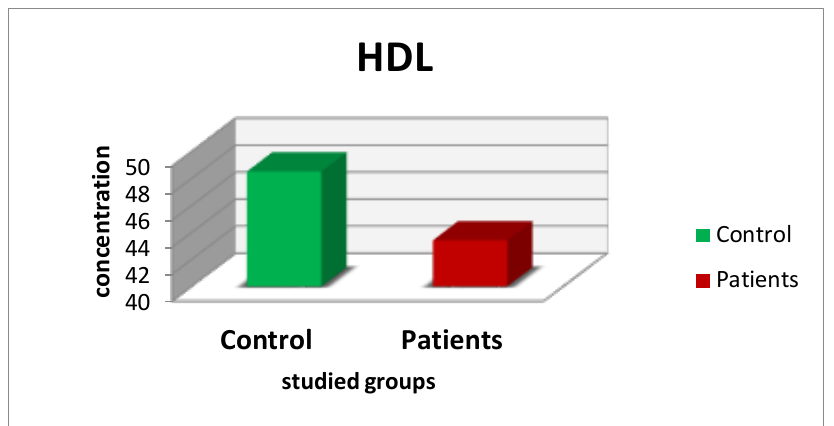
Figure 8: Levels of high-density lipoprotein in patients and control